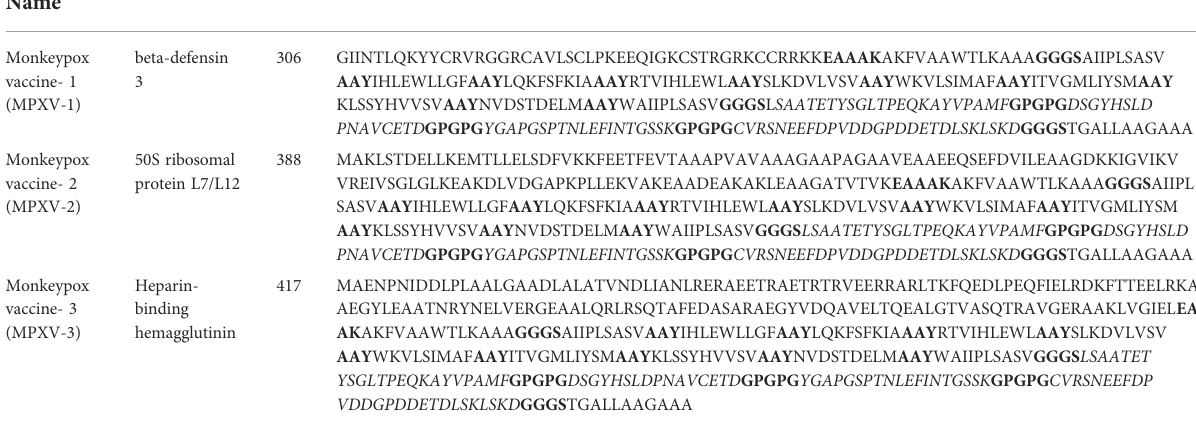
TABLE 3 The amino acid sequence of MPXV-1 – 3 ensemble. An adjuvant is inserted at the N-terminal of the vaccine ensemble. EAAAK linker connecting the PADRE sequence to the adjuvant is represented in bold letters. Vaccine Adjuvant Length Vaccine Ensemble Name